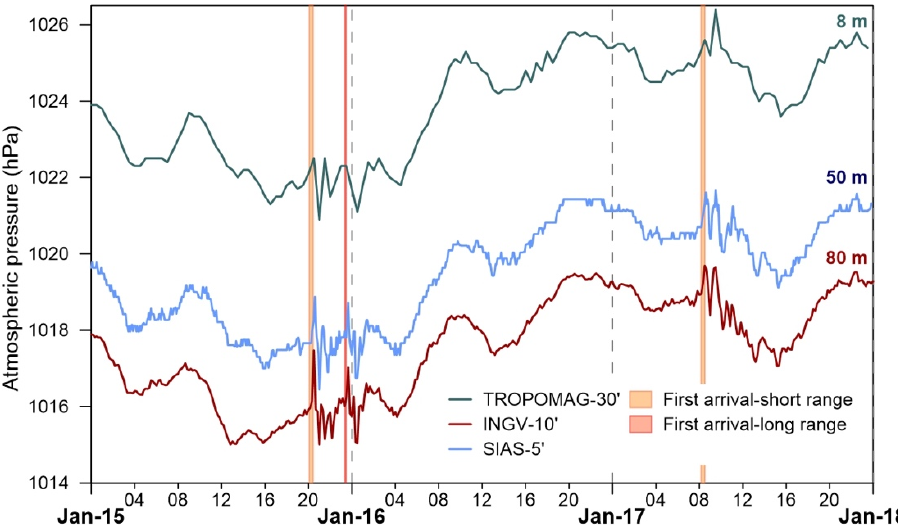
Figure 3. Barometric signals, sampled at 5, 10 and 30 min by different stations located in the city of Palermo (Figure 1). The numbers on the right represent the elevation above sea level of the stations. Orange vertical bars indicate the first arrival of the first and second passage of the shockwave travelling along the short range, the red one the passage of the shockwave along the long (antipodal) range.